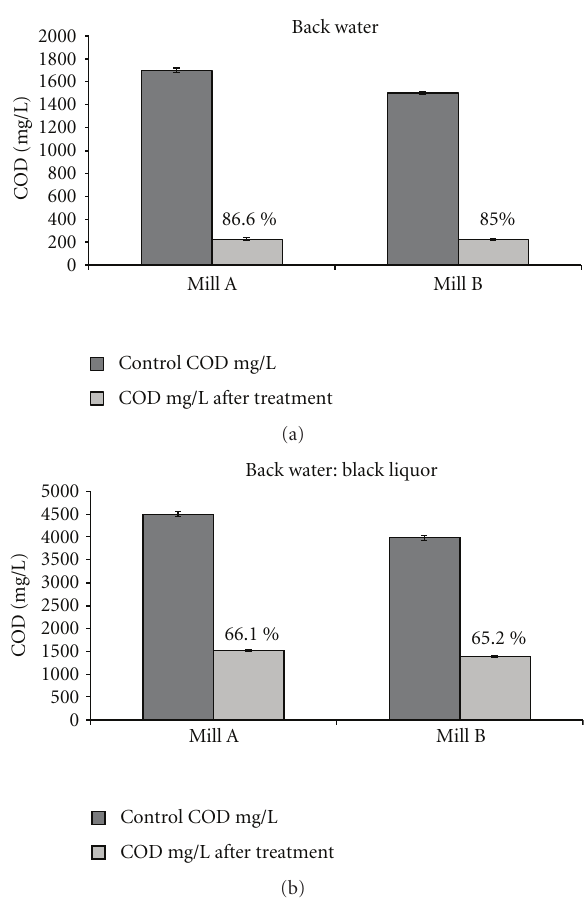
Figure 4: COD reduction of sample (back water 100%) and (back water :black Liquor 80 :20) using C6 consortia under optimized conditions (pH 6.8, temperature 35 ◦ C, and shaking